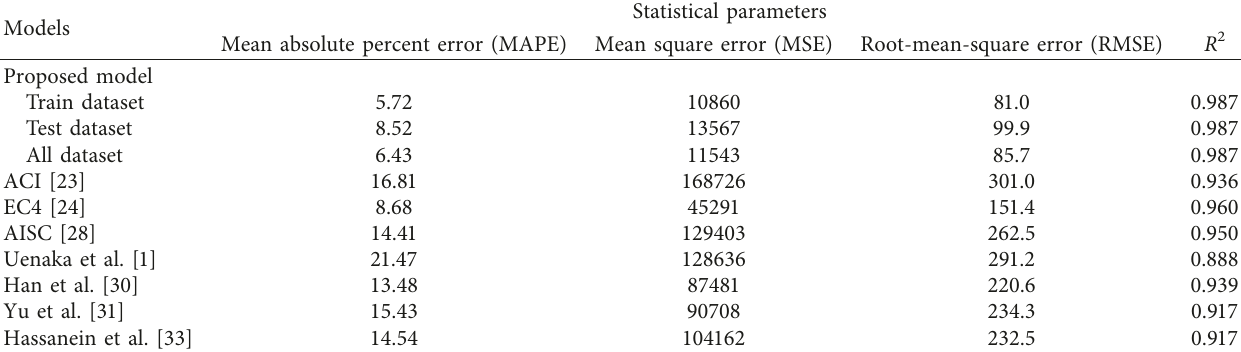
Table 5: Statistical parameters of the proposed and existing